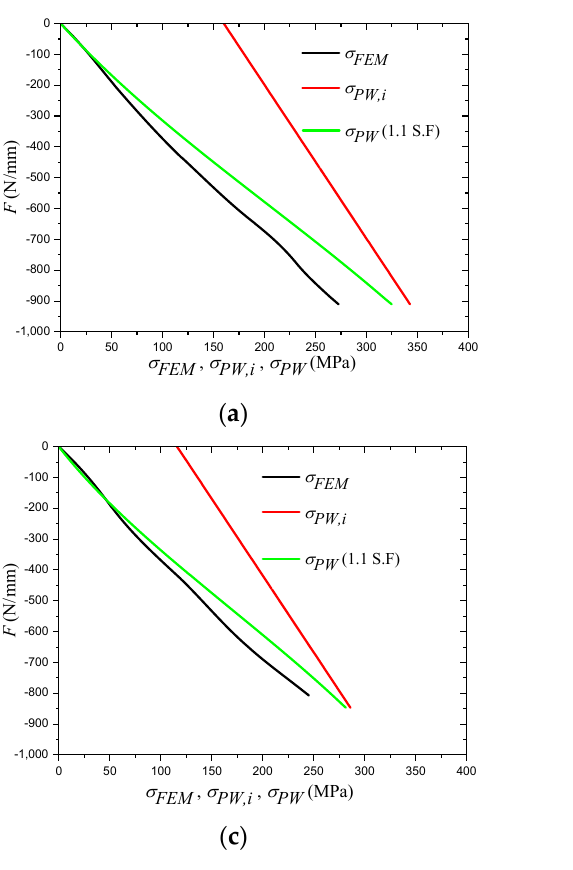
Figure 20. Influence of The Applied Vertical Load. ( a ) Sample 1; ( b ) Sample 2; ( c ) Sample 3; ( d ) Sample 4.